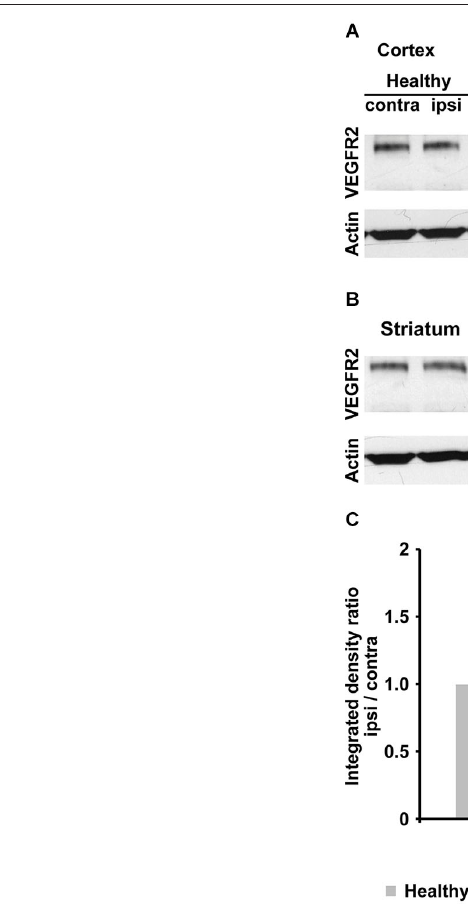
Representative Western blots from striatal tissue samples. Strongest elevation is visible in the 14d MCAO group. (C) Semi-quantification (including normalization to actin) and subsequent normalization to the intact hemisphere reveals significant increased VEGFR2 expression in the ischemic cortex ( p = 0.005) and ischemic striatum ( p = 0.048) (* p < 0.05, ** p <